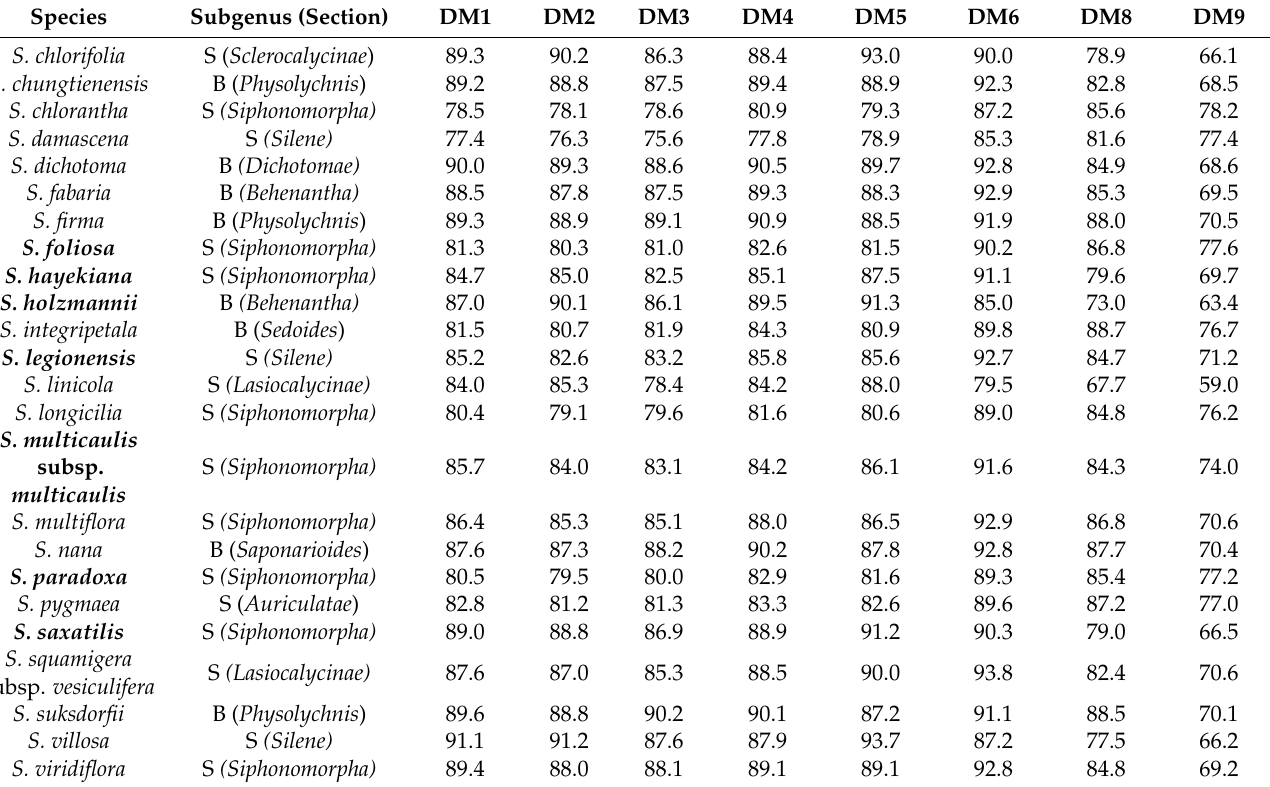
Table A5. Values of J index for the average silhouettes of each species with seven dorsal models. Species reaching maximum in models DM5 or DM6. In bold: species that did not reach the threshold value of 89.0 for the J index estimated as the mean of 20 seeds. B: corresponds to S. subg. Behenantha ; S: corresponds to S. subg. Silene